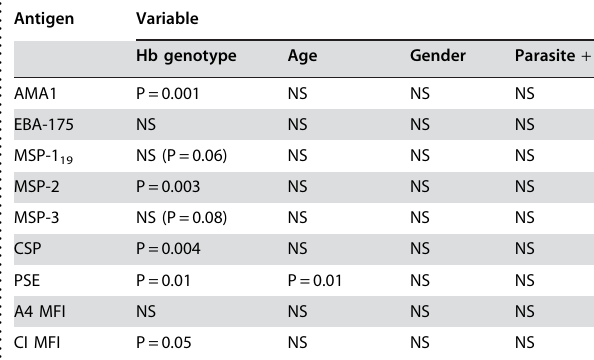
Table 4. Logistic regression analysis of antibody levels